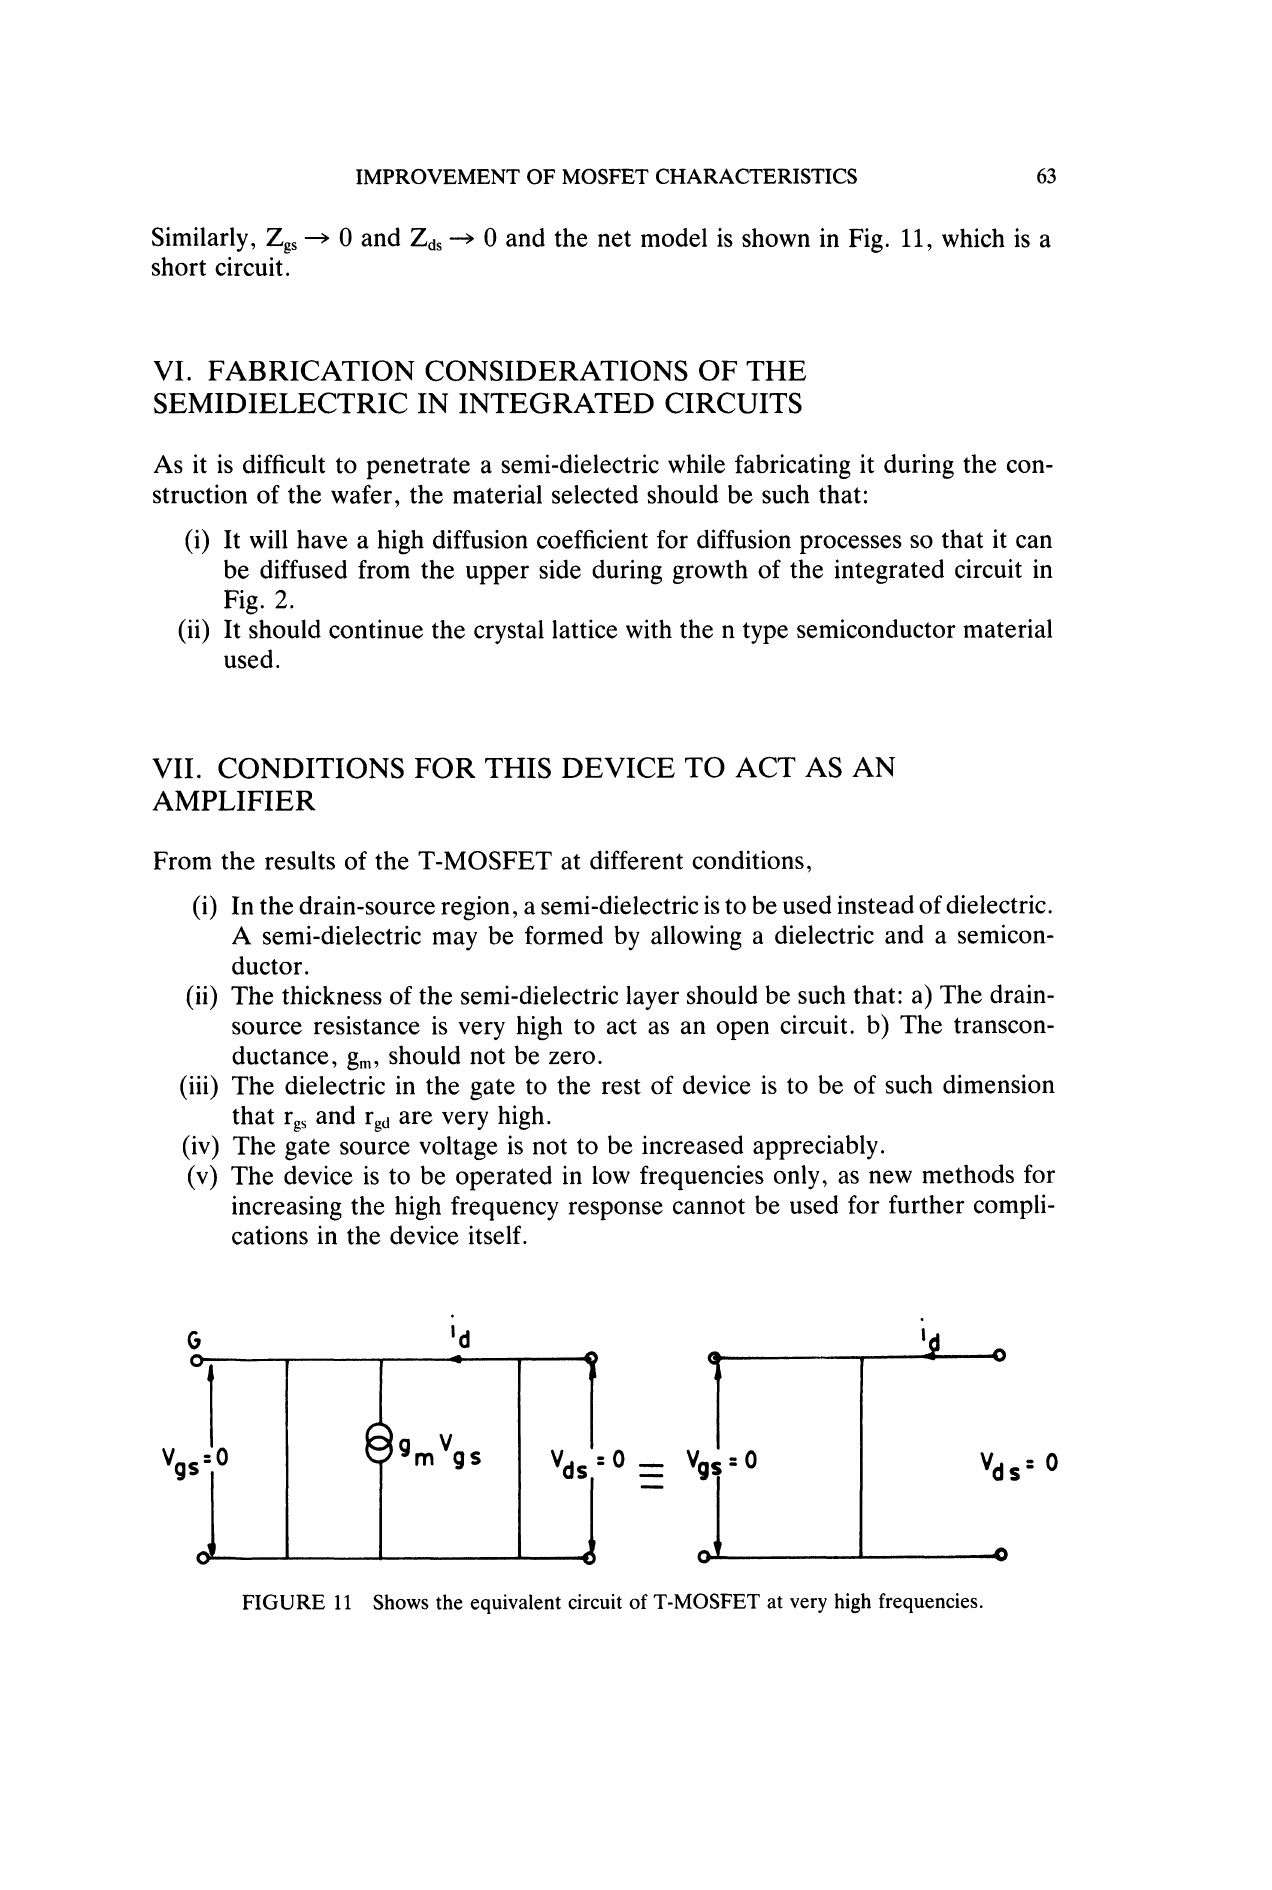
FIGURE 11 Shows the equivalent circuit of T-MOSFET at very high